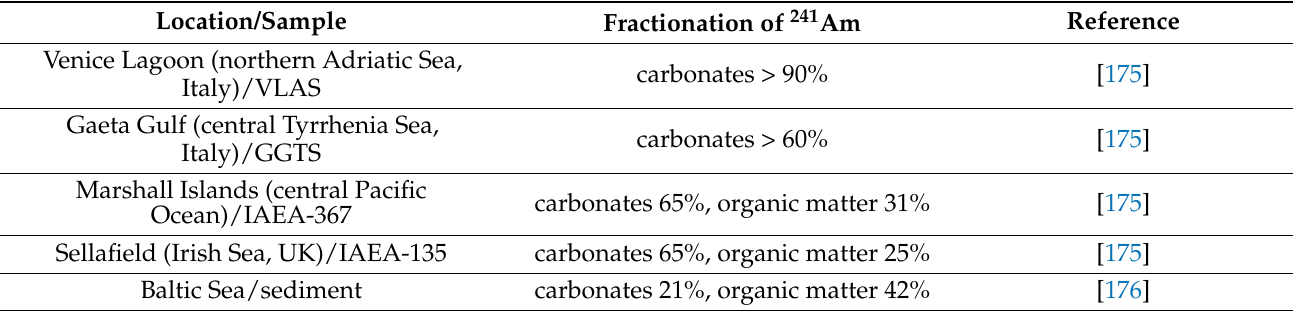
Table 12. Distributions of 241 Am in different fractions in sea